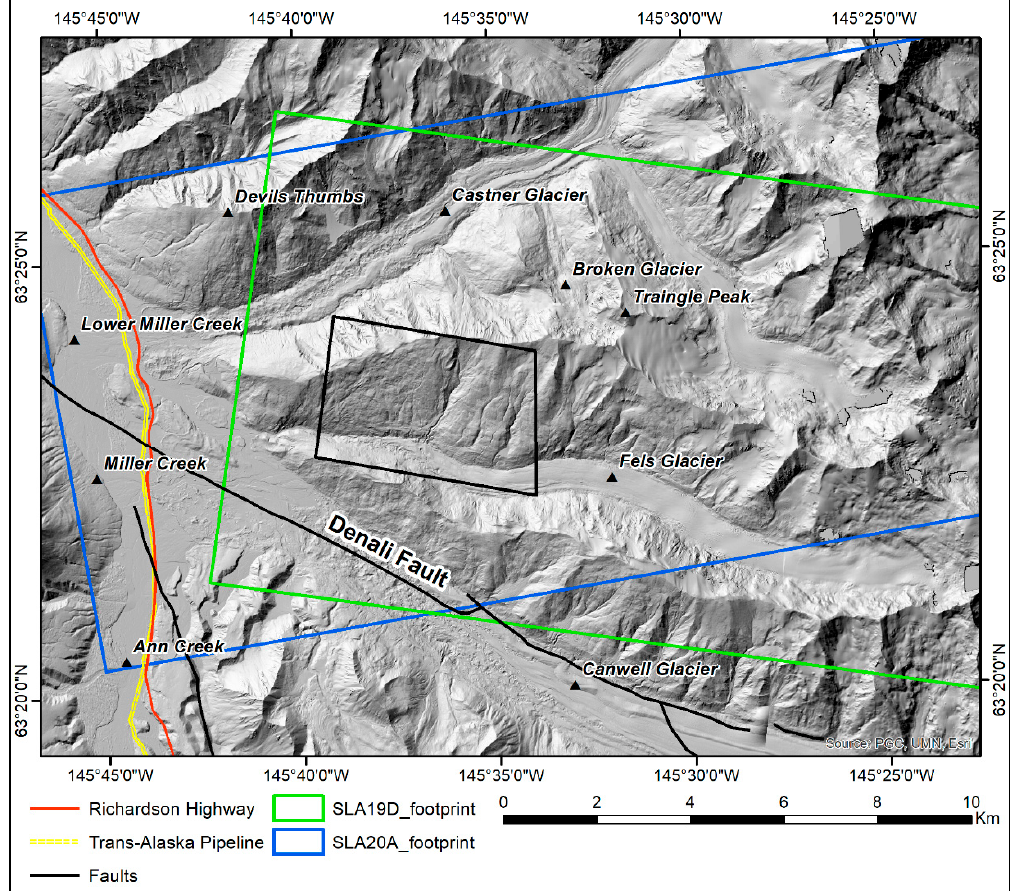
Figure 4. RADARSAT-2 footprints over the area of interest, with the descending-orbit footprint boundary indicated in green and the ascending boundary in blue.